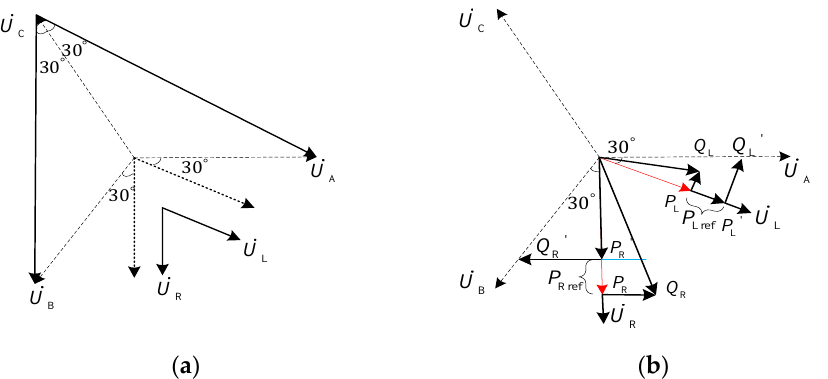
Figure 3. Phasor diagram. ( a ) Voltage phasors at primary and secondary sides; ( b ) phasor diagram of power compensation.